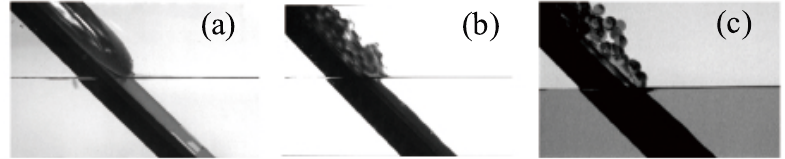
Figure 9. Raw images of landslides intruding into a body of water, as recorded by a high-speed camera: ( a ) Carbopol, ( b ) mixture of 50% Carbopol and 50% polymer–water balls, and ( c ) polymer–water balls.